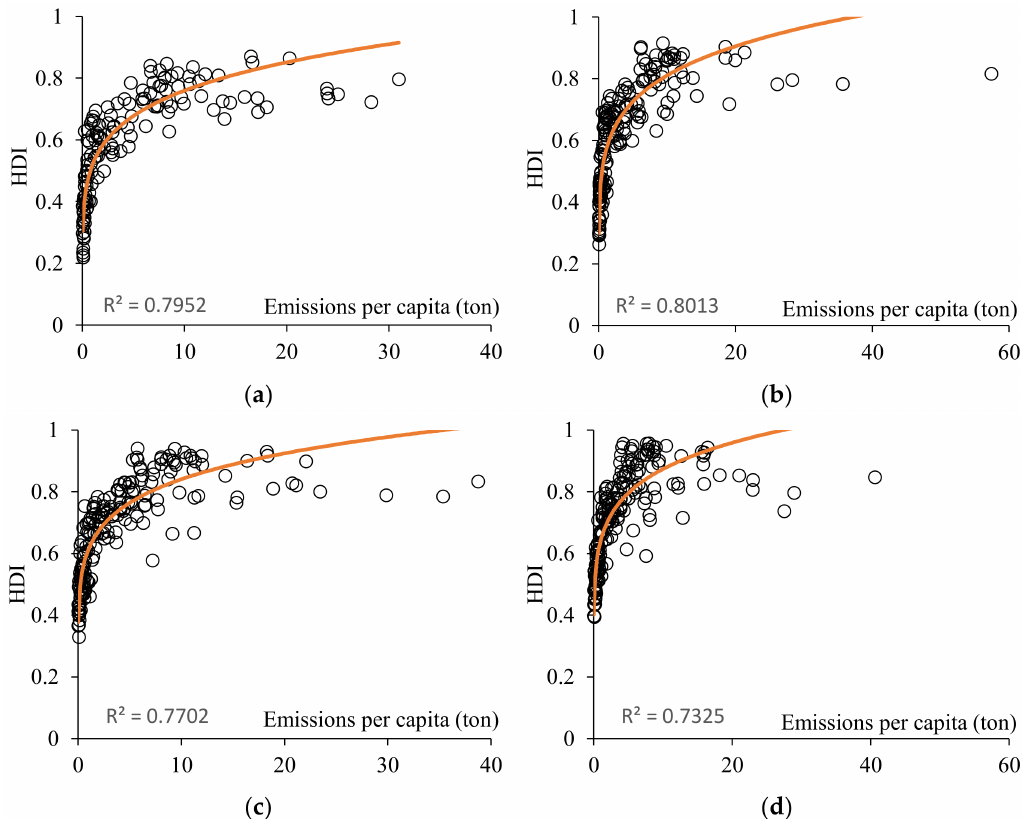
Figure 1. Relationship between HDI and CO 2 per capita emissions. Source: Authors’ own con- struction. Note: The p -values for the four exponential functions are all less than 0.01 and pass the significance test. ( a ) 1990; ( b ) 2000; ( c ) 2010; ( d )